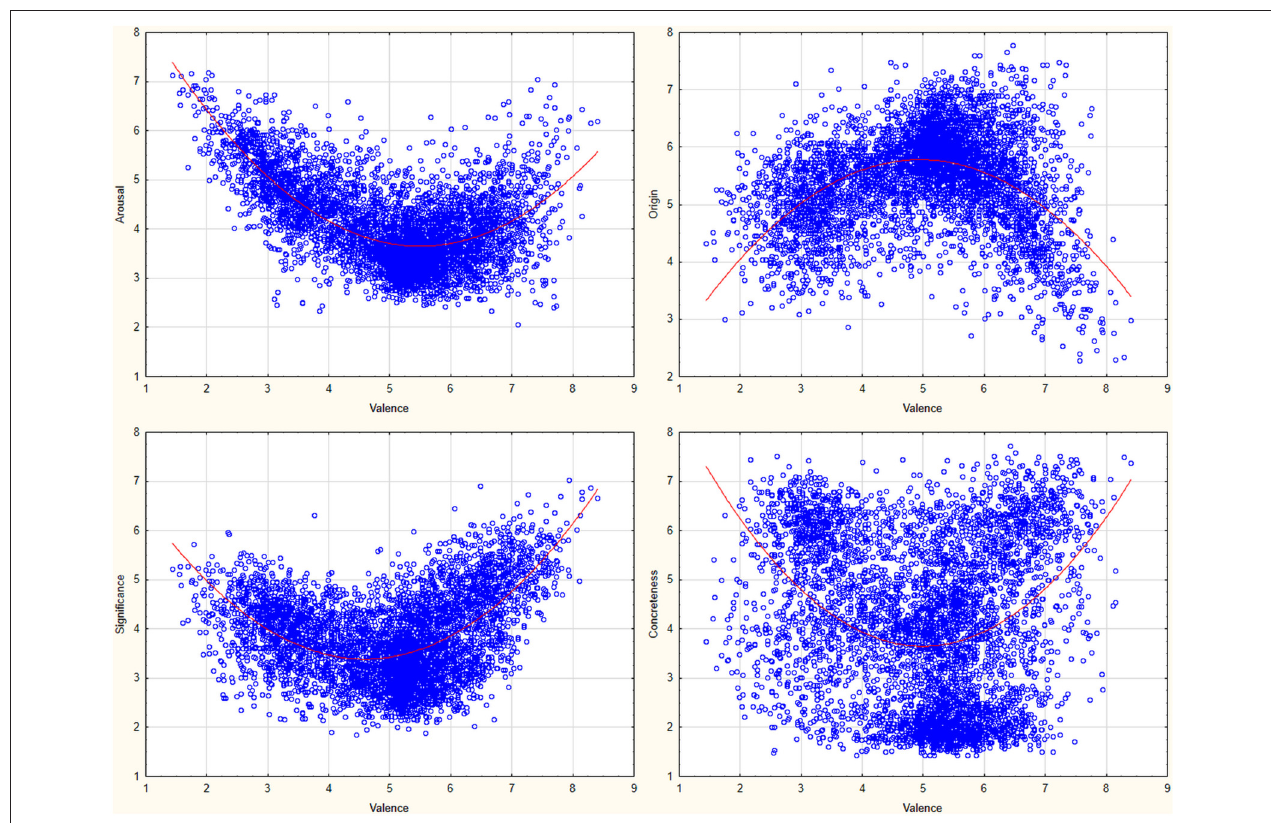
FIGURE 4 | Bimodal affective spaces distribution for dimensions correlated to valence in quadratic